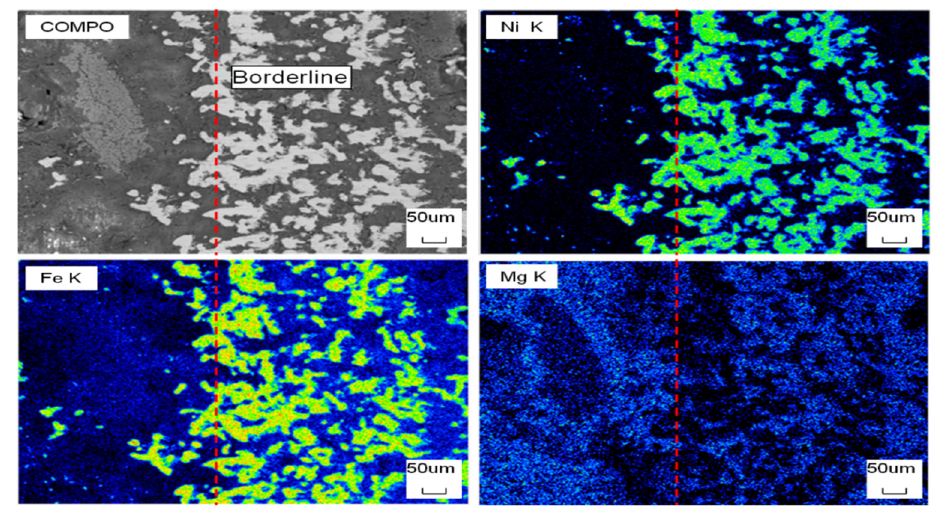
Figure 16. EDS mapping of the cross section of DC3; the red dot line was borderline of raw ore and concentrate.